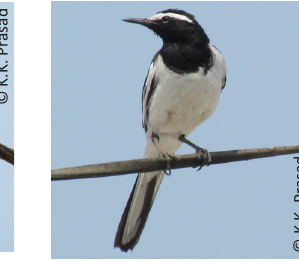
Image 50. Ashy-crowned Spar- row-Lark Eremopterix grisea